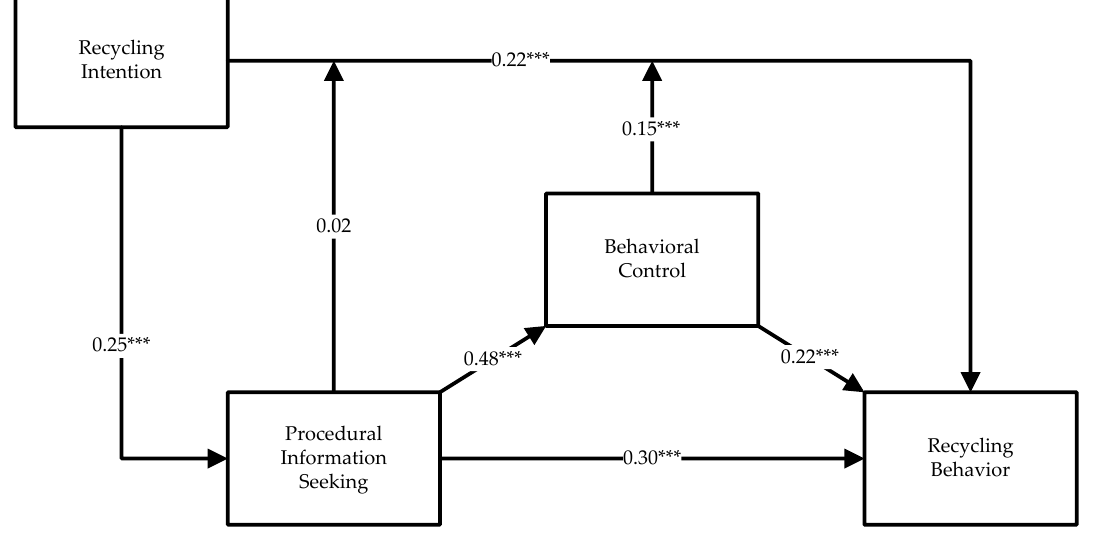
Figure 4. Diagram of observed effects. Note. *** p < 0.001.